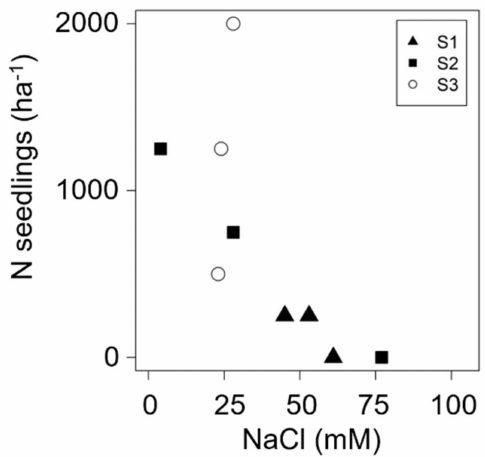
Figure 1. Salinity and seedling density at the three sites (S1–S3, see Table 1) in “Lame di